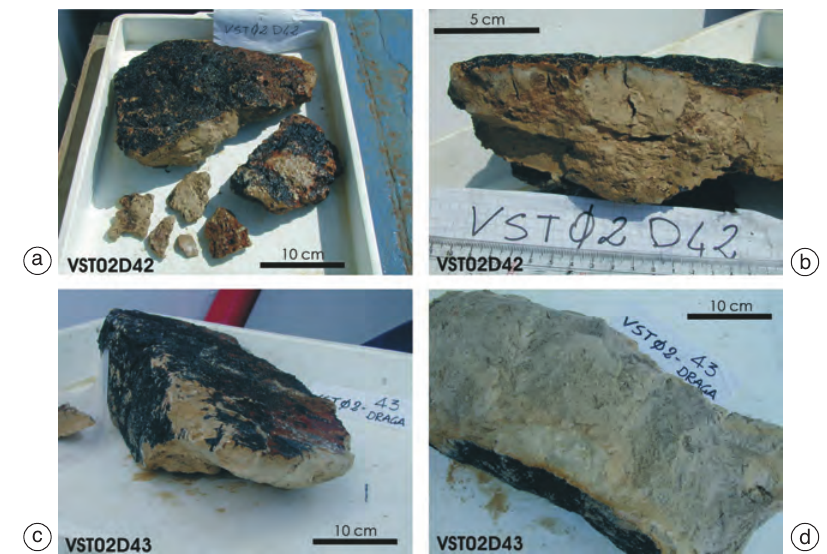
Fig. 8a-d. Selected samples of hardground crust paving some sectors of the Vavilov seamount: a) and b) from the southern flank; c) and d) from the southewestern flank.